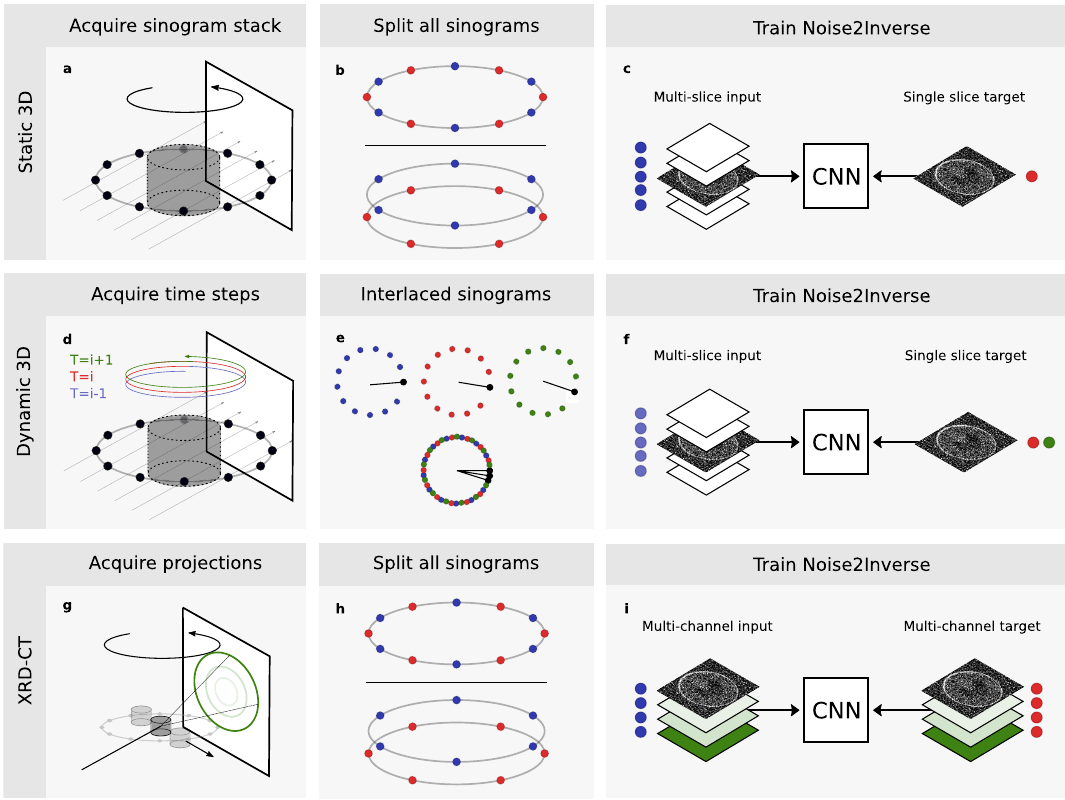
Figure 3. Noise2Inverse training procedures for several imaging techniques. ( a - c ), Static 3D micro- tomography. Acquisition produces a stack of sinograms ( a ), each of which is split in the angular domain ( b ). A 2.5D-CNN is supplied with the current input slice and several context slices (shown in white) reconstructed from one part of the sinogram (blue dot). The target slice is reconstructed from a different part of the sinogram (red dot). ( d - f ), Dynamic micro-tomography of an evolving process. Scans of multiple time steps are acquired ( d ). With interlaced acquisition, the angular sampling of each time step is slightly displaced with respect to the previous time step (indicated by the “clock’s hands”) ( e ). Denser angular sampling is achieved by combining the sinograms of multiple time steps ( e ). A 2.5D-CNN is trained on time steps where the dynamic process has not yet started ( f ). The input is a reconstruction of a single time step (blue dot), and the target is reconstructed from the sinograms of the other time steps (red and green dots). ( g – i ), X-ray diffraction computed tomography (XRD-CT). A pencil beam probes a rotating object that is moved sideways in steps ( g ). Diffraction of the beam gives rise to rings on the detector (in green). Azimuthal integration along rings at different radii yields several sinograms for each slice of the object. These sinograms are split in the domain of the rotation angle (blue and red dots) ( h ). From these sinograms, a multi-channel reconstruction is computed, representing the diffractogram of the object (in shades of green) ( i ). Training is performed with multi-channel inputs and multi-channel targets, with inputs and targets reconstructed from distinct parts of the sinograms (blue and red